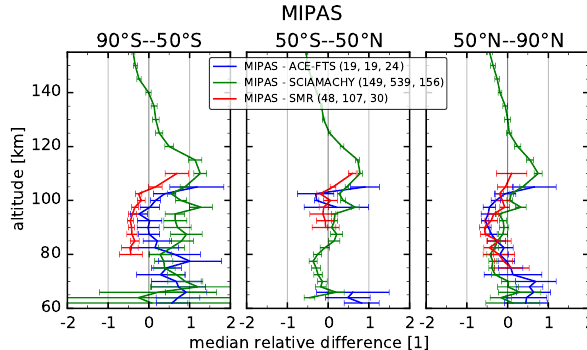
Figure 6. NO vertical profile comparison of MIPAS NO data n MIPAS . For a detailed description see Fig. NO